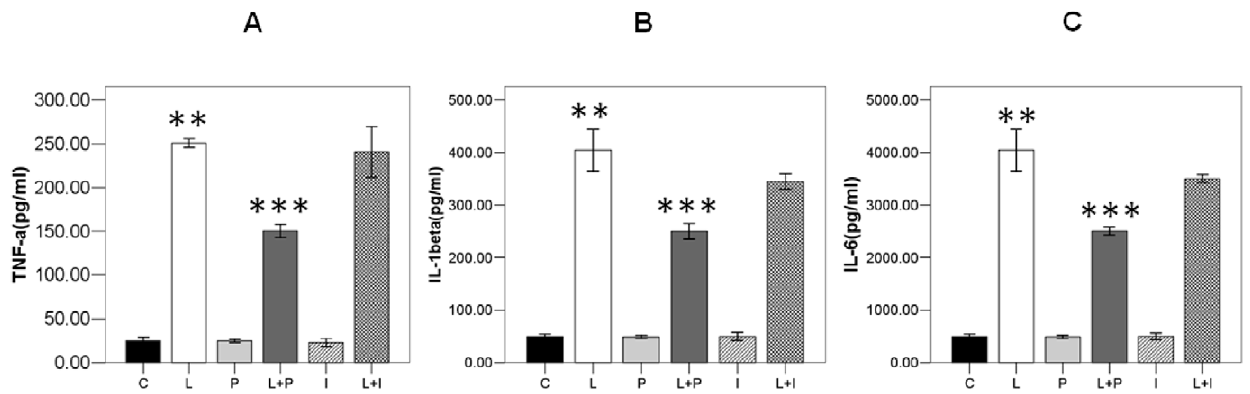
Figure 4. IL-1 b , IL-6 and TNF- a quantitization in the serum of six groups. A. ELISA confirmation of TNF- a in the serum of six groups. Each bar represents the mean 6 S.D, significant differences were found between L group and L + P Group(*p , 0.01, n=6). B. ELISA confirmation of IL-1 b in the serum of four groups. Each bar represents the mean 6 S.D, significant differences were found between L group and L + P Group(*p , 0.01, n=6). C. ELISA confirmation of IL-6 in the serum of four groups. Each bar represents the mean 6 S.D, significant differences were found between L group and L + P Group (*p , 0.01, n=6).